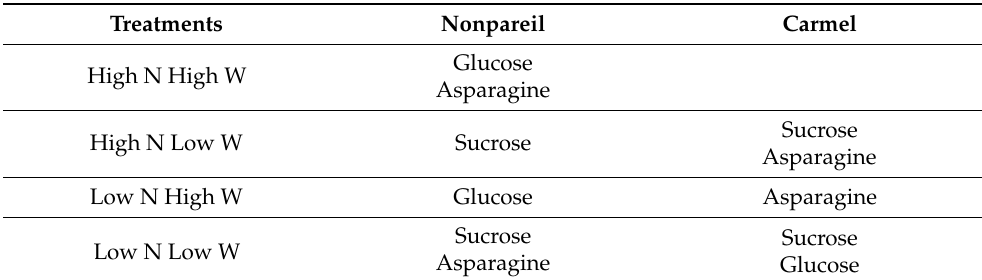
Table 1. Treatment effects causing relative increase in sucrose, glucose and/or asparagine in hulls of Nonpareil and Carmel almonds (from Figures 4 and